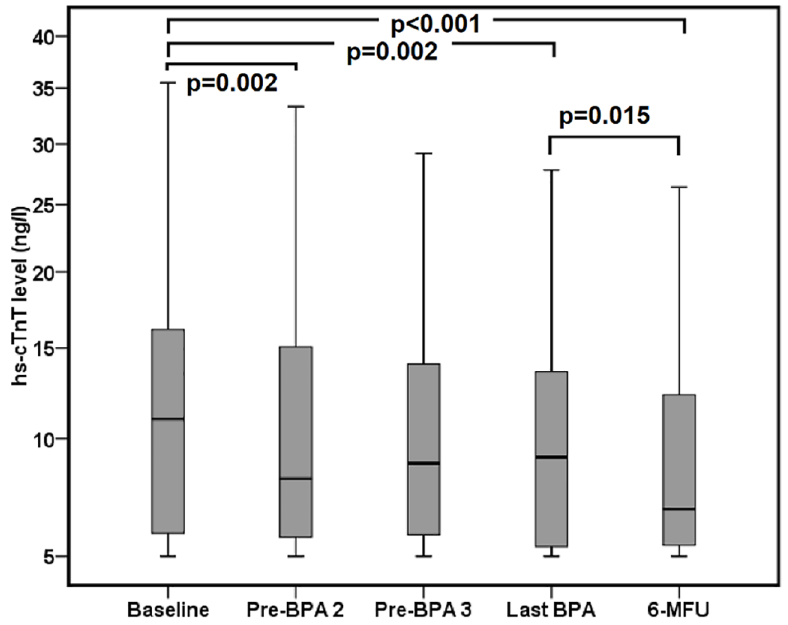
Fig 1. Analysis of the time course of hs-cTnT levels during staged BPA procedure (BPA = Balloon pulmonary angioplasty, hs-cTnT = high-sensitivity cardiac troponin T, 6-MFU = 6-month follow-up).